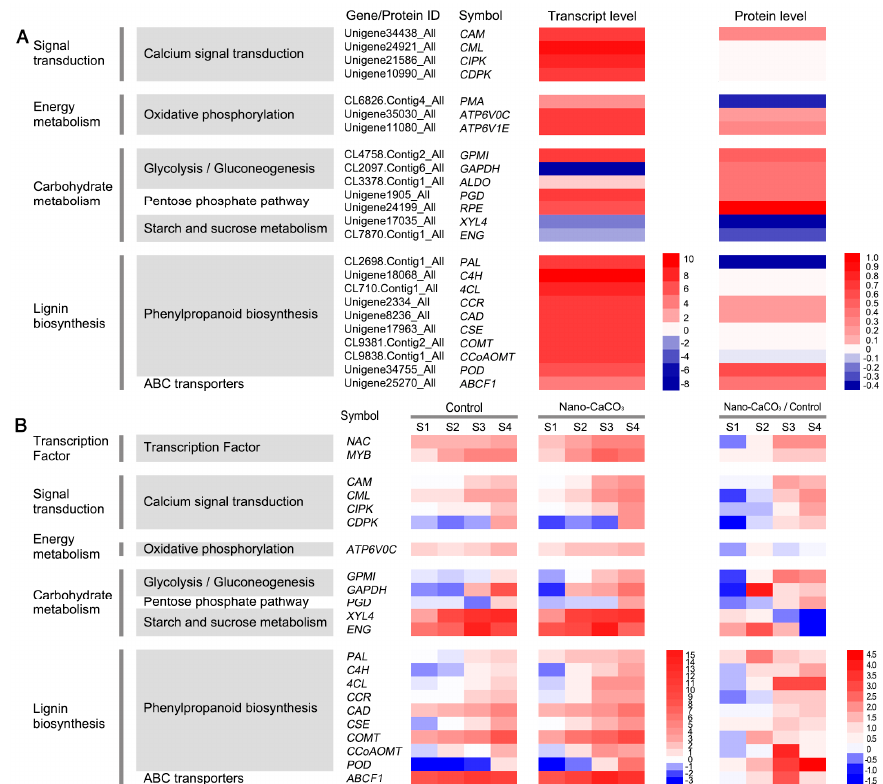
Figure 4. Heat maps of the expression of the genes. ( A ) Heat maps of correlated DEG and DEP expression involved in signal transduction, energy metabolism, carbohydrate metabolism, and lignin biosynthesis, with green indicating a decrease and red indicating an increase. ( B ) Heat maps of the expression of the 22 protein-encoding genes during four developmental stages. The log2 relative expression levels of 22 protein-encoding genes in the Control, nano-CaCO 3 treatment, with red color indicating a higher expression level and blue color indicating a lower expression level. The ratio of relative expression levels of 22 protein-encoding genes in nano-CaCO 3 /Control, with red color indicating an increase and blue indicating a decrease. CAM , Calmodulin gene; CML , Calmodulin-like protein gene; CIPK , calcineurin B-like protein-interacting protein kinase gene; CDPK , calcium-dependent protein kinase gene; ATP6V0C , V-type H + -transporting ATPase 16kDa proteolipid subunit gene; GPMI , 2,3-bisphosphoglycerate-independent phosphoglycerate mutase gene; GAPDH , glyceraldehyde 4-phosphate dehydrogenase gene; PGD , 6-phosphogluconate dehydrogenase gene; XYL4 , xylan 1,4-beta-xylosidase gene; ENG , endoglucanase gene; PAL , phenylalanine ammonia-lyase gene; C4H , cinnamate 4-hydroxylase gene; C4L , 4-coumarate-CoA ligase gene; CCR , cinnamoyl-CoA reductase gene; CAD , cinnamyl-alcohol dehydrogenase gene; CSE , caffeoyl shikimate esterase gene; COMT , caffeic acid 3- O -methyltransferase gene; CCoAOMT , caffeoyl-CoA 3- O -methyltransferase gene; POD , peroxidase gene; ABCF1 , ABC subfamily F member 1. S1, flower-bud stage; S2, pigmented stage; S3, unfold-petal stage; S4, full-flowering stage.